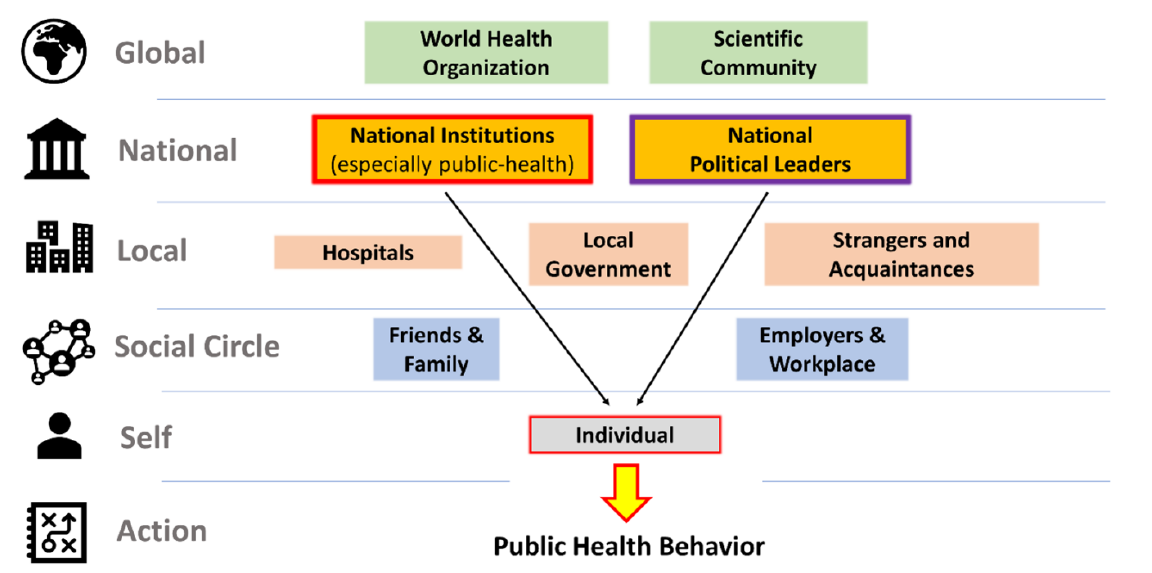
Figure 1. Hierarchical structure of trust during a public health crisis.